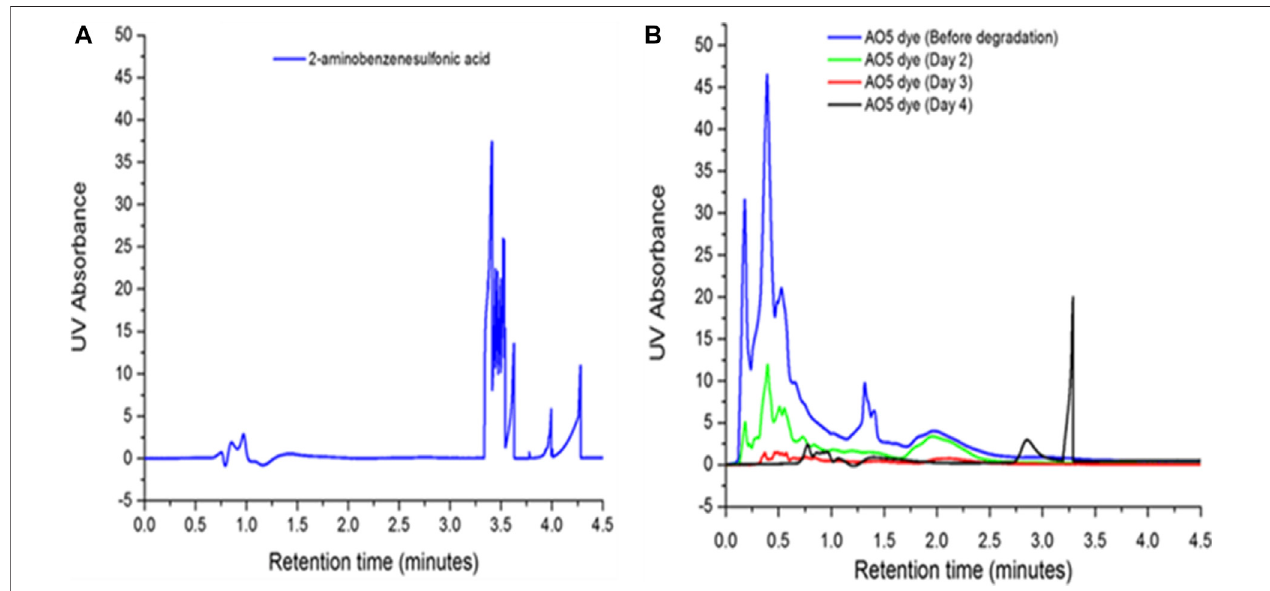
FIGURE 9 | UV-HPLC spectrum (A) Standard peak of 2-aminobenzenesulfonic acid (B) Degradation peaks of AO5 dye and apperance of new metabolities.